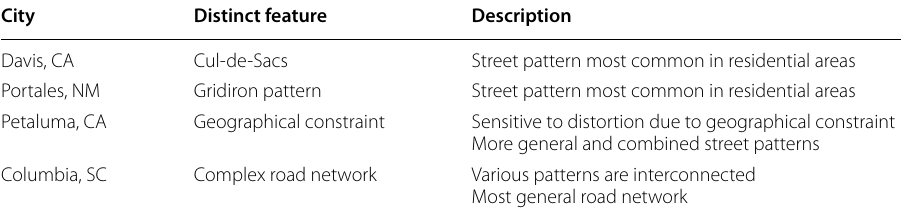
Table 1 Four cities with distinct features and the description of street pattern in the cities City